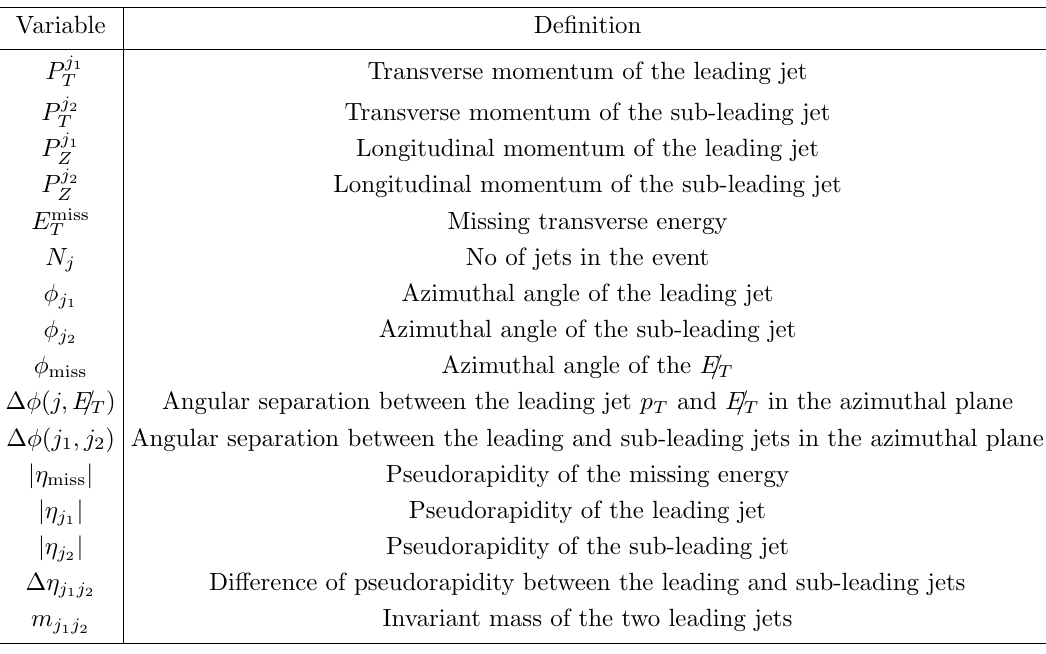
Table 8 . Input variables for XGBoost and ANN analysis for vector boson fusion. Azimuthal angles are measured with reference to some arbitrary x